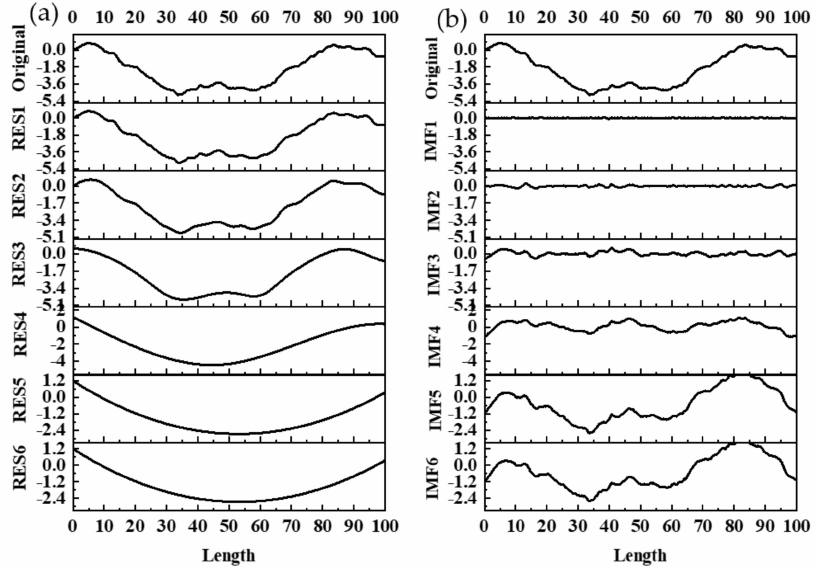
Figure 3. The EEMD results of the 6 # standard JRC profile ( a ) Approximate component, ( b ) Detail